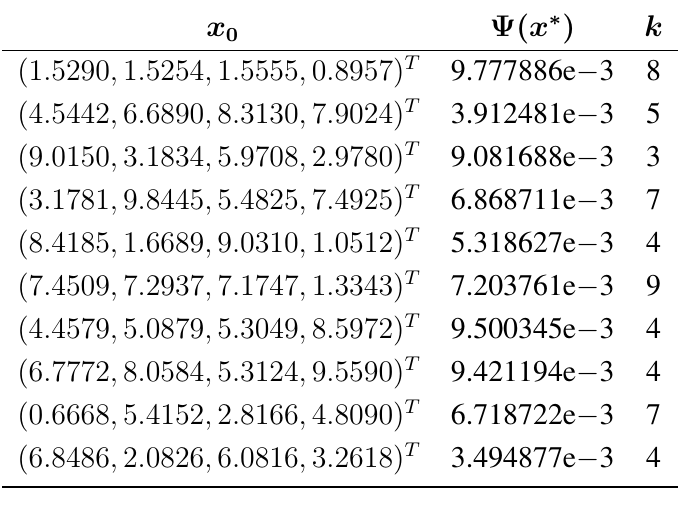
Table 9. Number of iterations and the final value of Ψ( x ∗ ) .